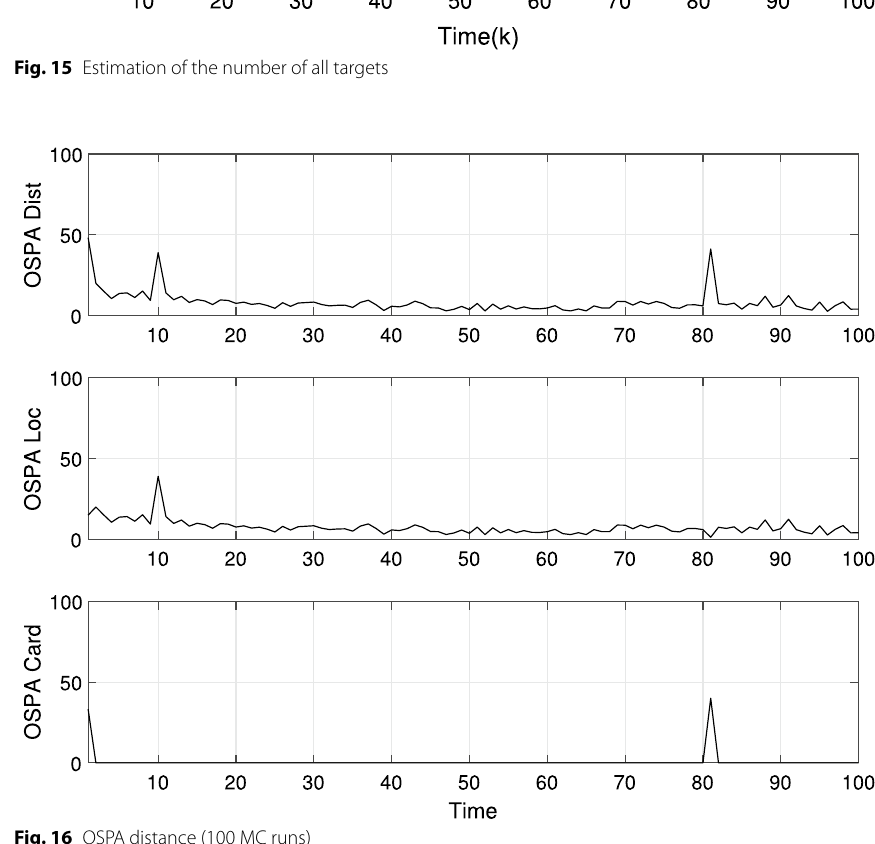
Fig. 16 OSPA distance (100 MC